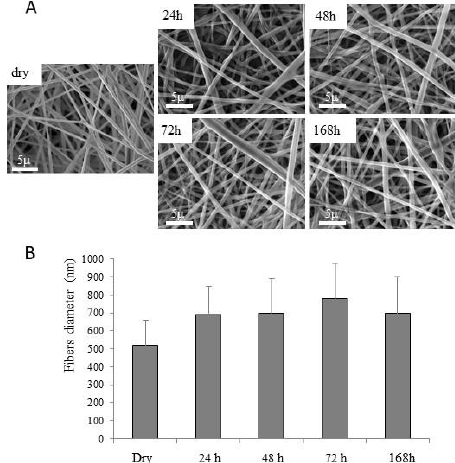
Figure 10. Photomicrographs SEM ( A ) of 1:1 weight ratio collagen / PCL nanofibers in dry and hydrated states from 24 h up to 1 week (168 h) at room temperature, and size diameters comparison ( B ) (mean values ± s.d., n = 60).